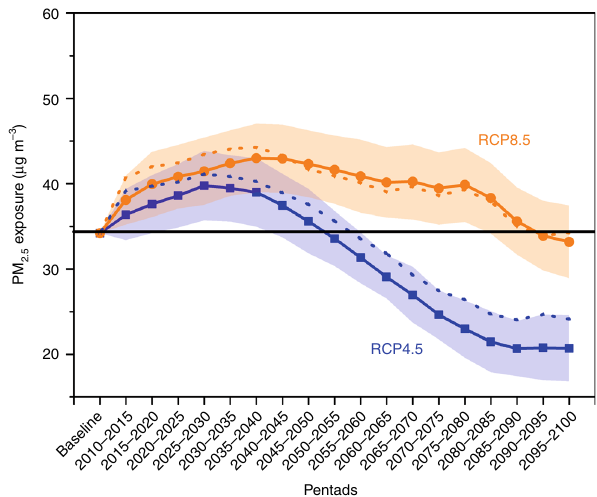
Fig. 1 Projected ambient PM 2.5 exposure over the Indian landmass. Projected PM 2.5 exposure is averaged over India for future under both RCP4.5 and RCP8.5 scenarios. Shaded part represents the range (1 – 99%) in all-India averaged PM 2.5 across the 13 CMIP5 models. The black line represents the all-India averaged baseline (2001 – 2005) PM 2.5 exposure level. Solid and dashed lines indicate the projected exposure using approach 1 and approach 2,